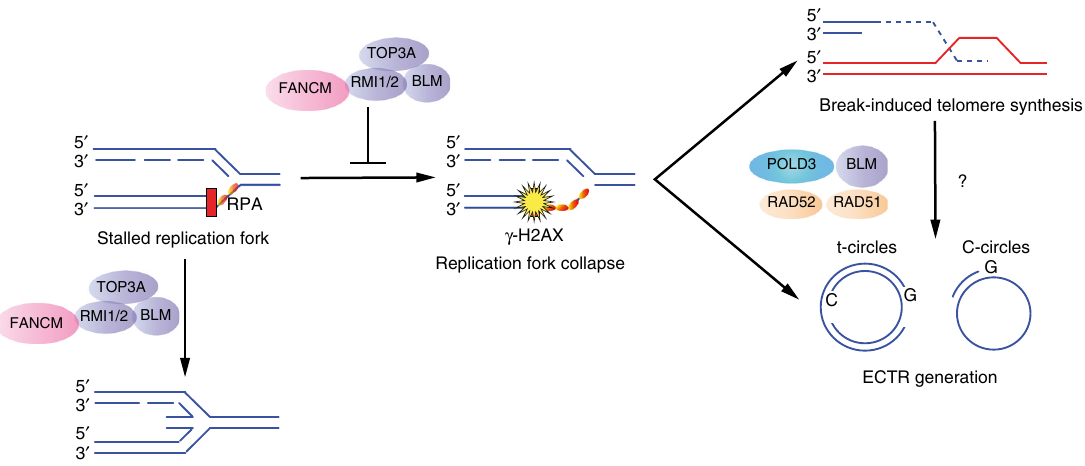
Fig. 6 Schematic of proposed model of FANCM-mediated ALT suppression. FANCM functions to reverse and remodel stalled replication forks that predominate in ALT telomeres. In the absence of FANCM, or through disruption of the FANCM-BTR complex, stalled forks deteriorate into double strand breaks, which provide the substrate for break-induced telomere synthesis events and the concomitant production of nascent